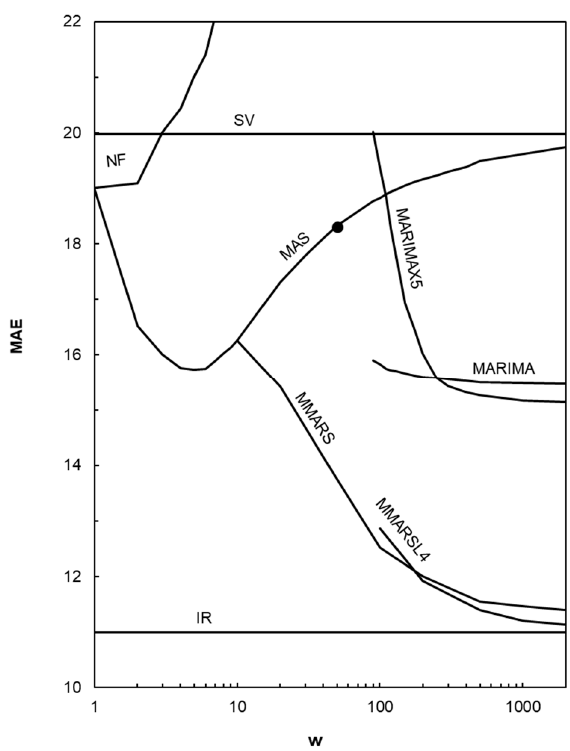
Figure 6. Comparison of the mean absolute error (MAE) resulting with different methods: Standard Value (SV), Naïf Forecasting (NF), Moving Average Smoothing (MAS), Moving ARIMA (MARIMA), Moving ARIMA with 5 eXogenous predictors (MARIMAX5), Moving MARS (MMARS), Moving MARS with 4 Lagged terms as additional predictors (MMARSL4) and IR thermometry. The results are represented as a function of the width of the training window, w . The initial situation is represented with a solid circle. Table 4. Main requirements for the considered